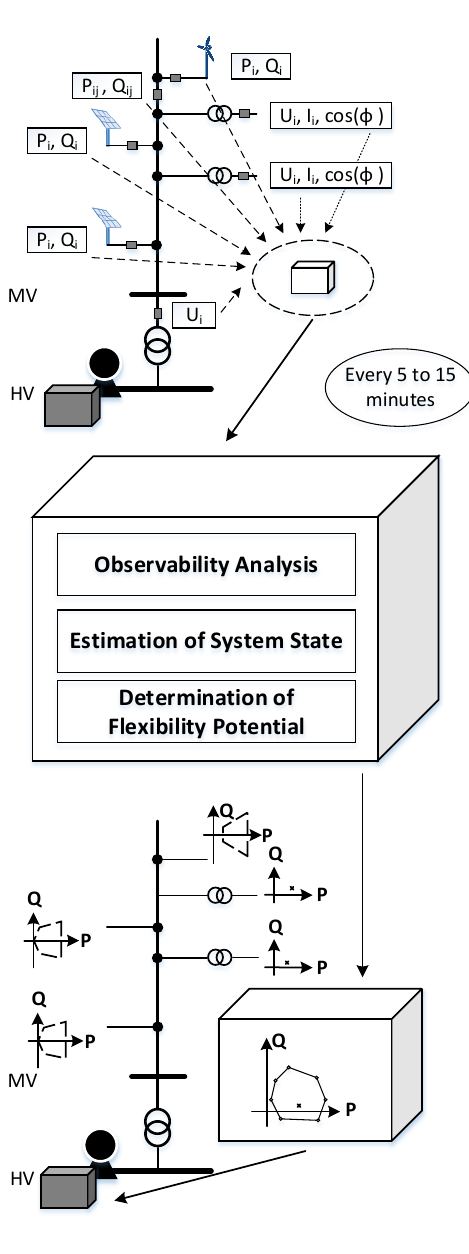
Figure 2: Overview field